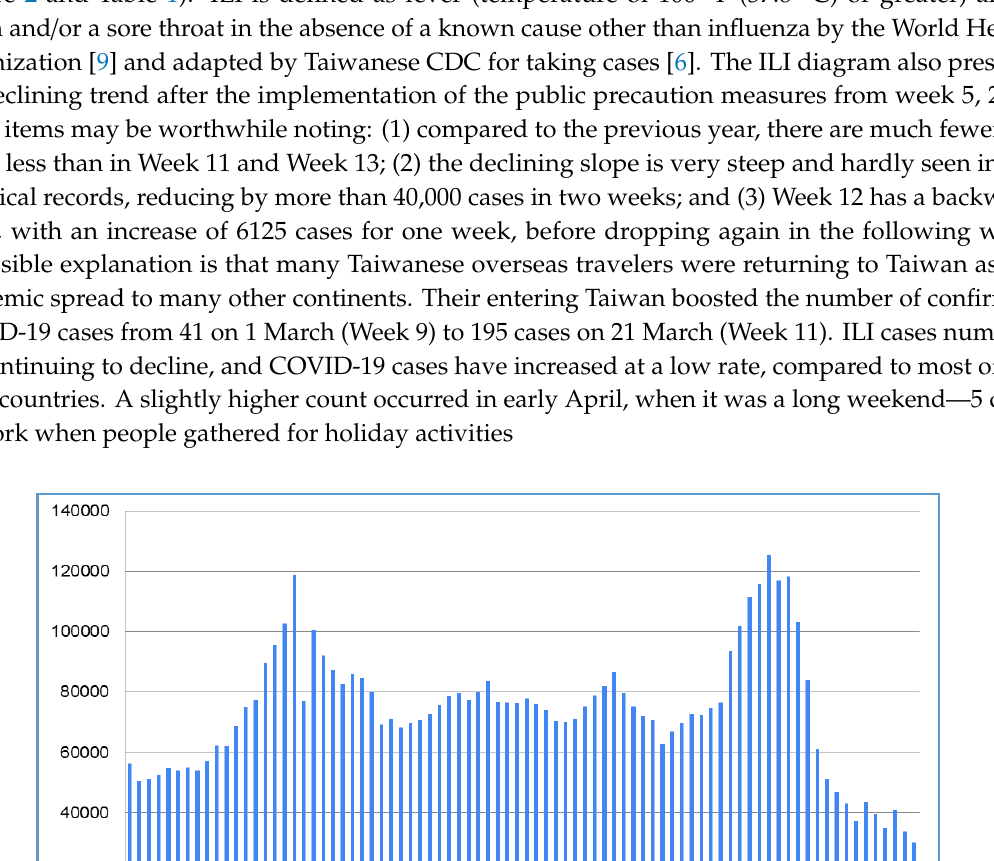
Figure 1. ( a ) Data extracted from Taiwanese Centers for Disease Control (Taiwan CDC) [6]. ( b ) Data extracted from American Centers for Disease Control and Prevention (US, CDC) [7]. Note: The figure shows the weekly records of confirmed influenzas A + B cases from 2018 to 2020: a comparison of cases in the US and Taiwan. x -axis: Year-Week interval & y -AXIS: number of cases.